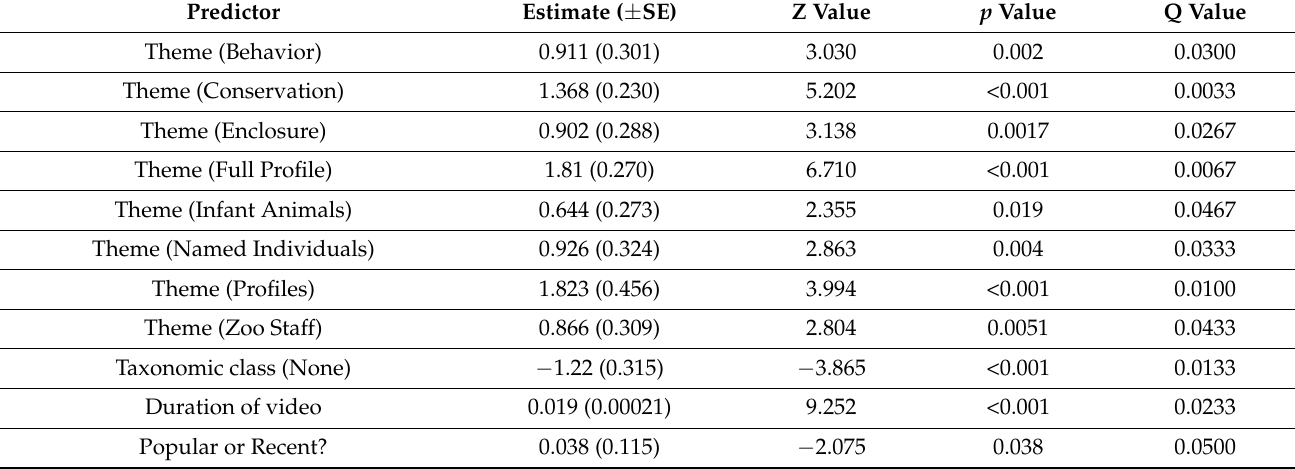
Table 6. Predictors and education, model output for significant predictors of the number of educational points in YouTube videos for three large zoological